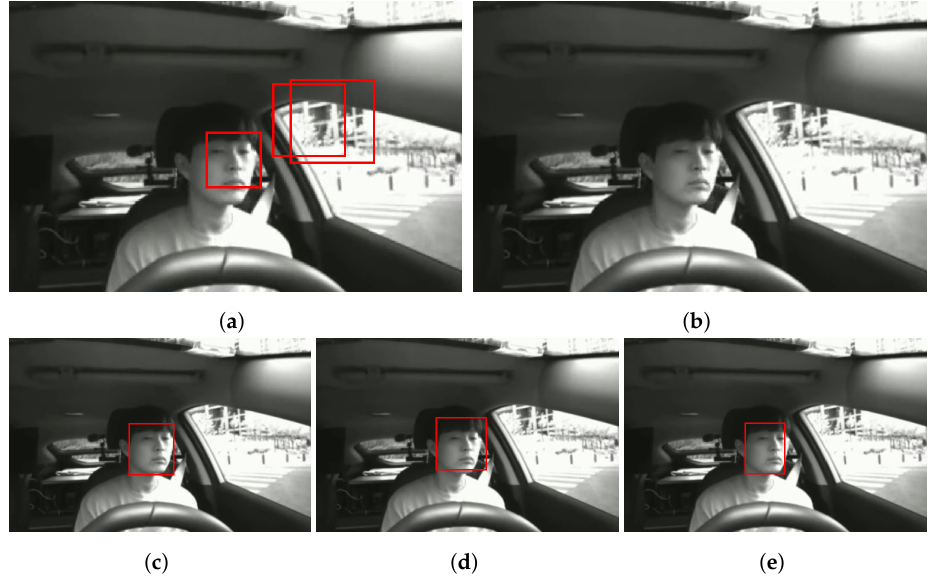
Figure 8. Example of the detection results of five face detectors. The bounding boxes (red) are face detection results. ( a ) Haar; ( b ) Dlib; ( c ) OpenCV; ( d ) MMOD; ( e )